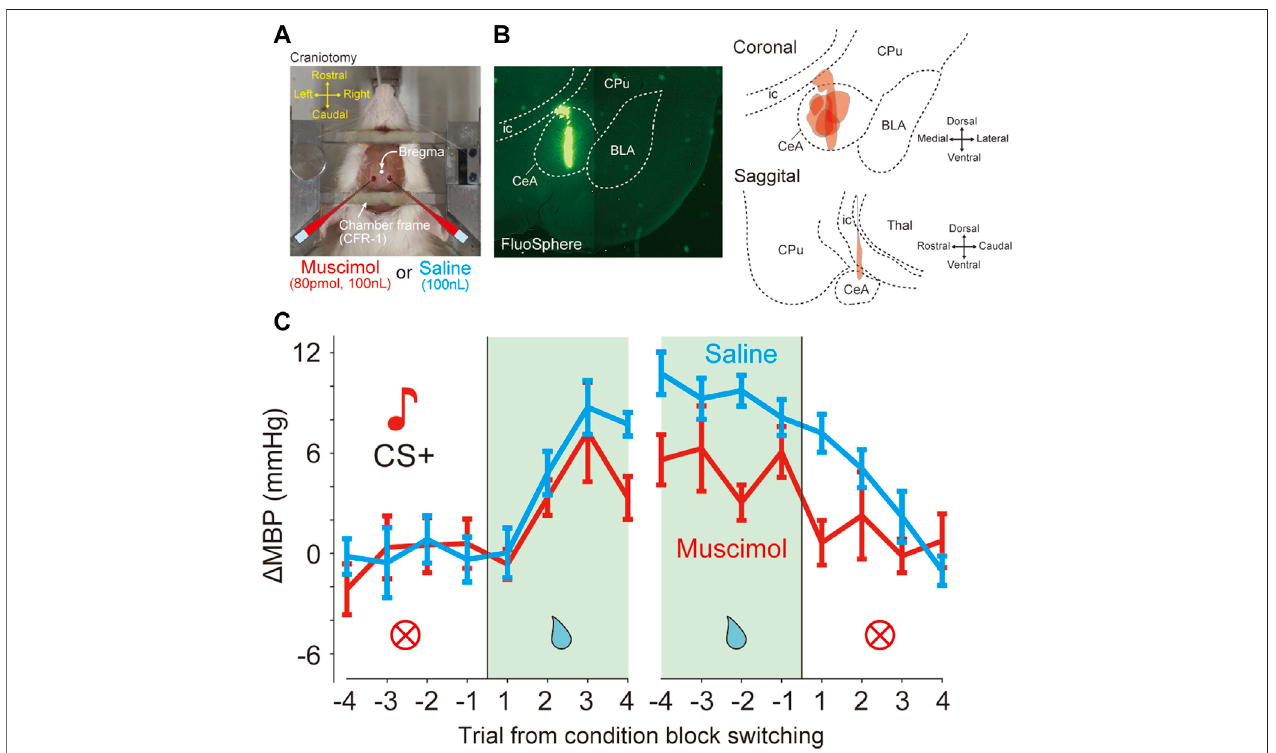
FIGURE 5 | Bilateral inactivation of CeA attenuated the pressor response induced by reward prediction (A) Photograph shows a view of a head-restraint rat from aboveduringdruginjection.Craniotomyjustabovetheamygdala(1.8 mmcaudal,3.0 mmlateralfrombregma)isperformedfordruginjection (B) Injectionsiteofsixrats inthebilateralCeA.Fluorospheres(100 nL)wereinjectedatidenticalstereotaxicpositionsusingglassmicropipettes (leftpanel).Reconstructionoftheinjectionsiteinthe coronal and sagittal planes (right panels). BLA, basolateral amygdala; CeA, central nucleus of the amygdala; CPu, caudate putamen; ic, internal capsule; Thal, thalamus. (C) Effectsofbilateralinactivationinthedataaveragedfromthemeanbloodpressure( Δ MBP)inresponsetoCS+beforeandafterfourtrialsatconditionblock switching during the dynamically changing classical conditioning tasks. Red and cyan lines indicate the data obtained with muscimol and saline injections (six rats).